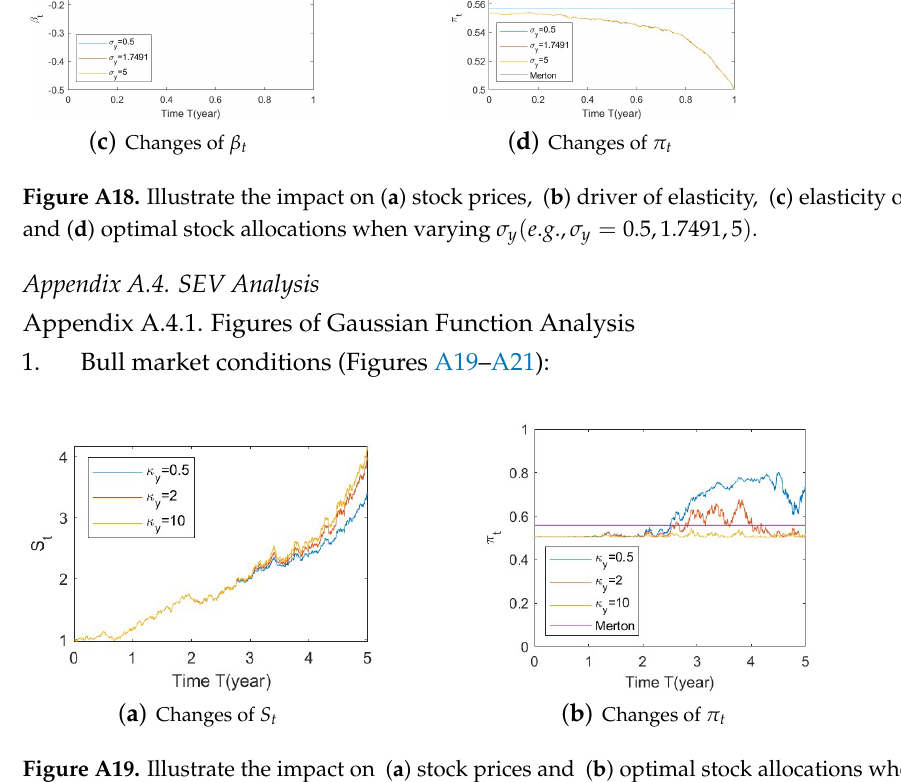
Figure A19. Illustrate the impact on ( a ) stock prices and ( b ) optimal stock allocations when varying the speed of reversion, κ y ( e . g ., κ y = 0.5,2,10 ) .